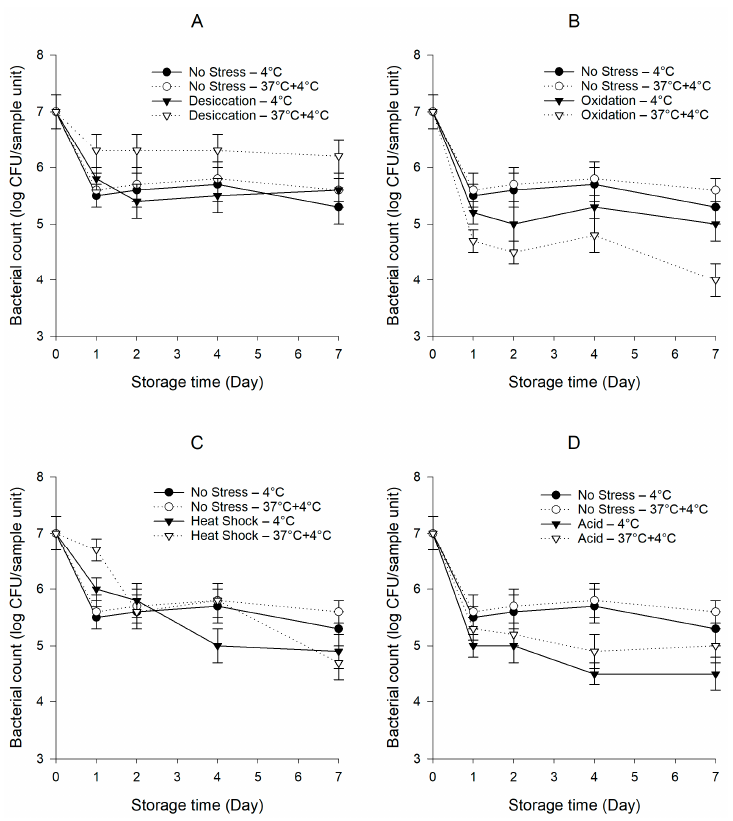
Figure 1. Persistence of the S. enterica cocktail on baby spinach under cold and temperature abuse conditions with or without prior exposure to sub-lethal desiccation ( A ), oxidation ( B ), heat shock ( C ), and acid ( D ) stresses. Error bars represent standard deviations (n = 3).